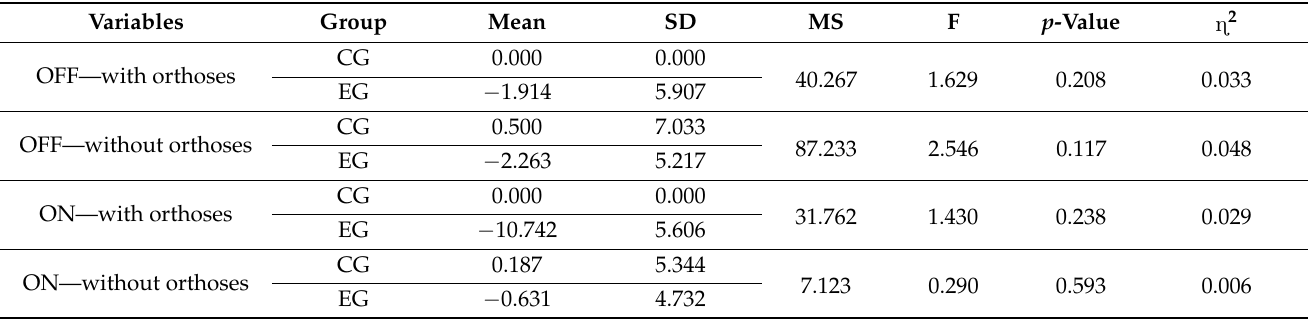
Table 5. Inter-group comparison of UPDRS-II differential score according to the type of group using